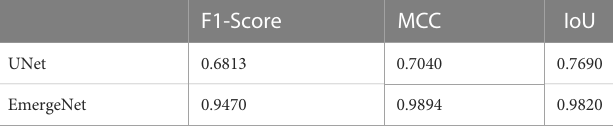
TABLE 1 Results of comparison between UNet and EmergeNet on UNL- MED under all lighting conditions in terms of F1-Score, MCC, and